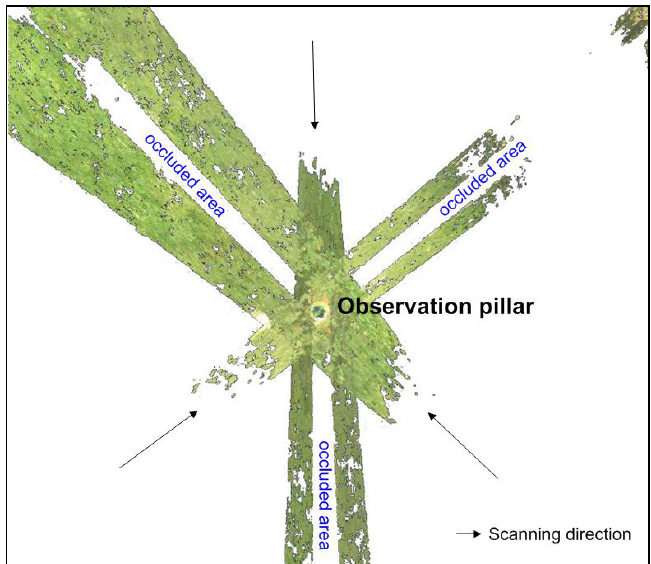
Figure 4. Scanner positions with respect to the observation pillars (top view). The adjacent point clouds had an overlap of approximately